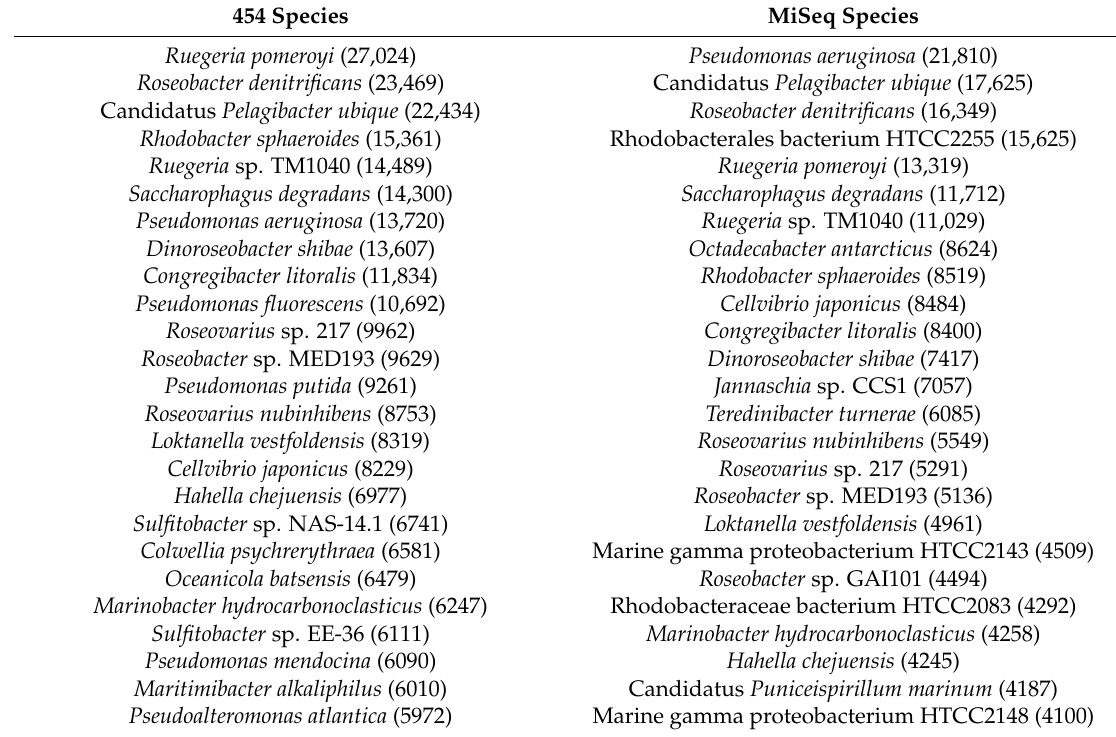
Table 1. Top 25 species in 454 and MiSeq data by